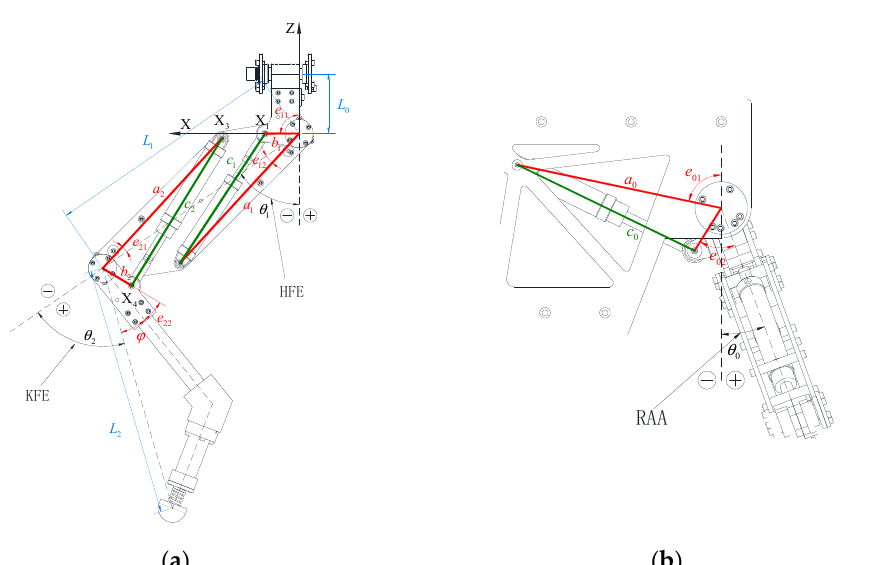
L , L , L ), the cylinder mounting 0 1 2 c , c , c ), joint angles ( 0 1 2